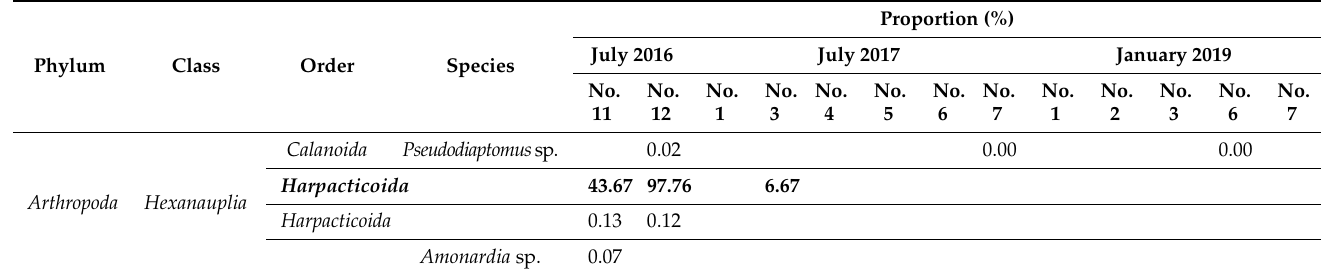
Figure 2. Length–weight relationship between specimens collected for each period. The white circles Figure 2. Length – weight relationship between specimens collected for each period. The white cir- were taken in July 2017, and the black circles were taken in January 2019. cles were taken in July 2017, and the black circles were taken in January 2019. Table 3. The results of genetic analysis of gut (up to the species level). Bold font indicates the results of further analysis up to the order level for the results showing “unknown” in the analysis up to the species